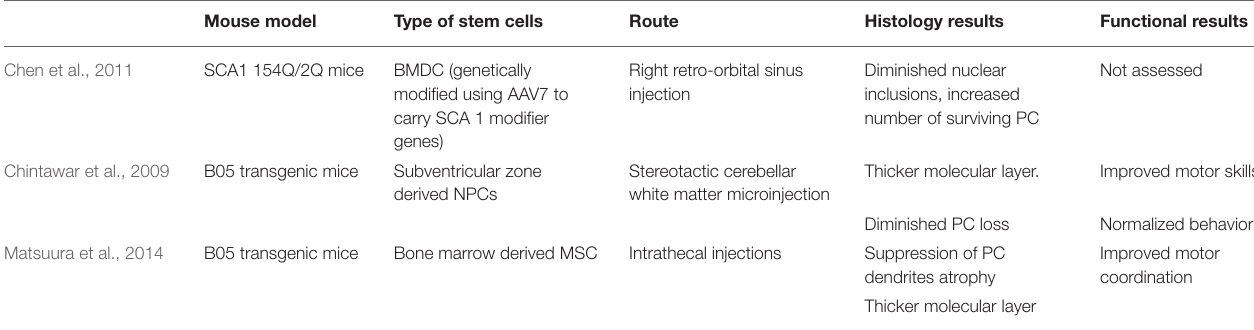
TABLE 4 | Overview of stem cell therapies for SCA